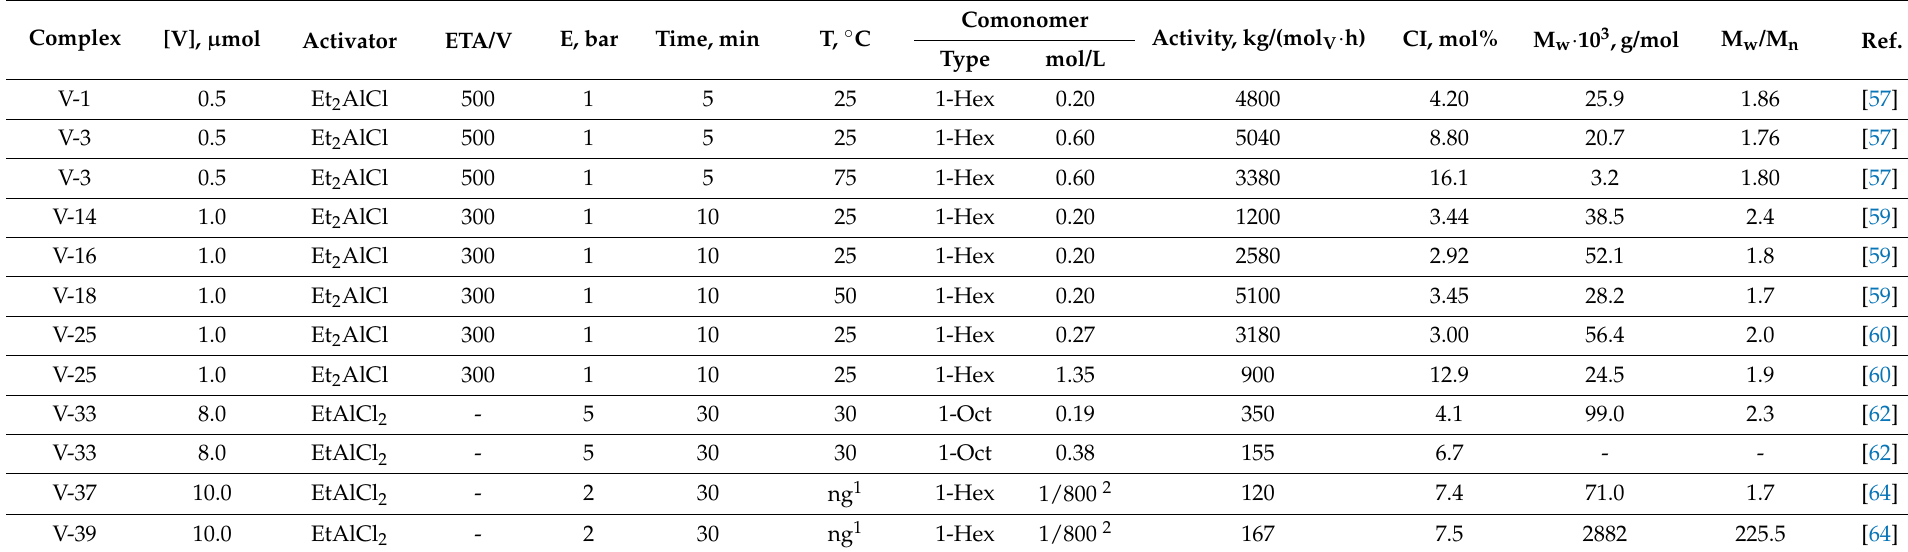
Table 5. Results of ethylene/1-olefin copolymerization with vanadium